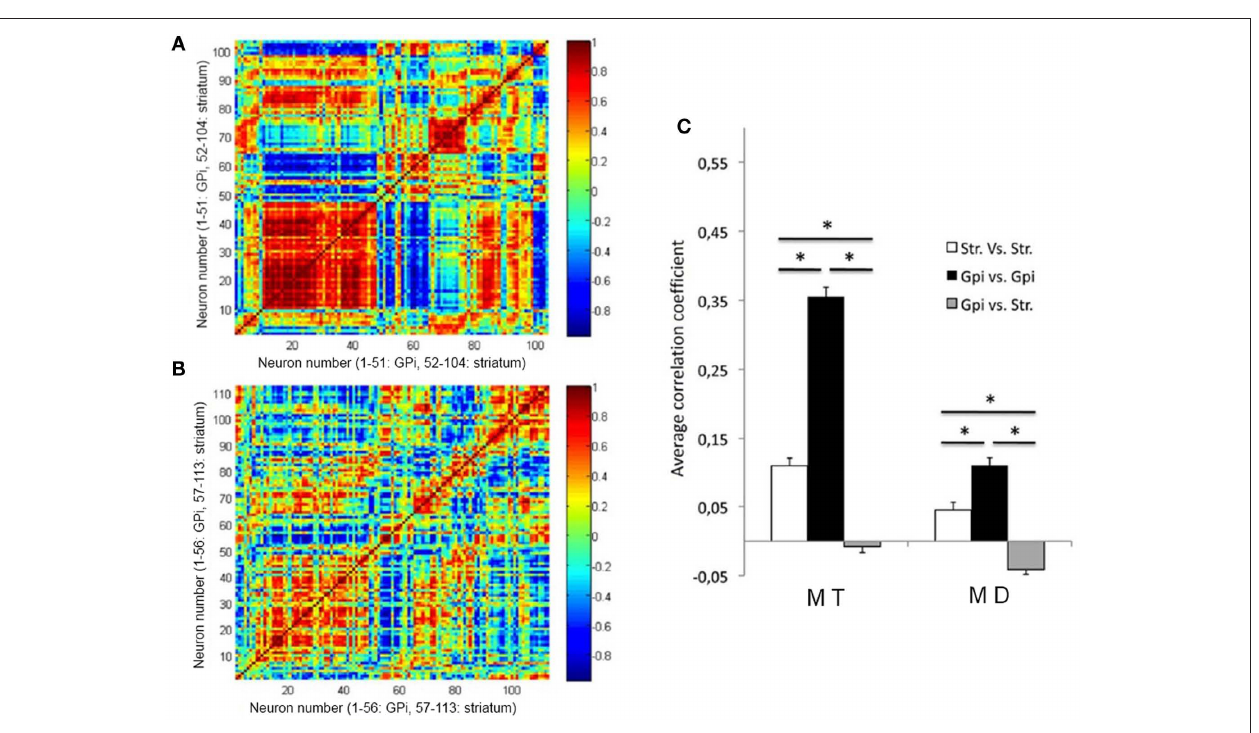
Figure 3 | Cross-correlation matrices of all the neuron NieTHs for monkey T (A) and monkey D (B). (C) Histograms of average correlation coefficient values of the neuron NIETHs. Color bar: correlation coefficient value, error bars indicate SEM (one-way ANOVA, p < 0.01, post hoc : Tukey’s least significant difference